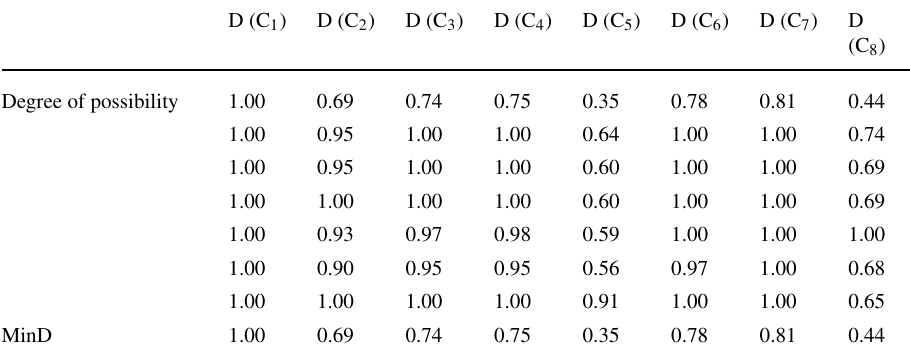
Table 7 Degree of possibility (D) and minimum degree of possibility (MinD) for the IRL problems